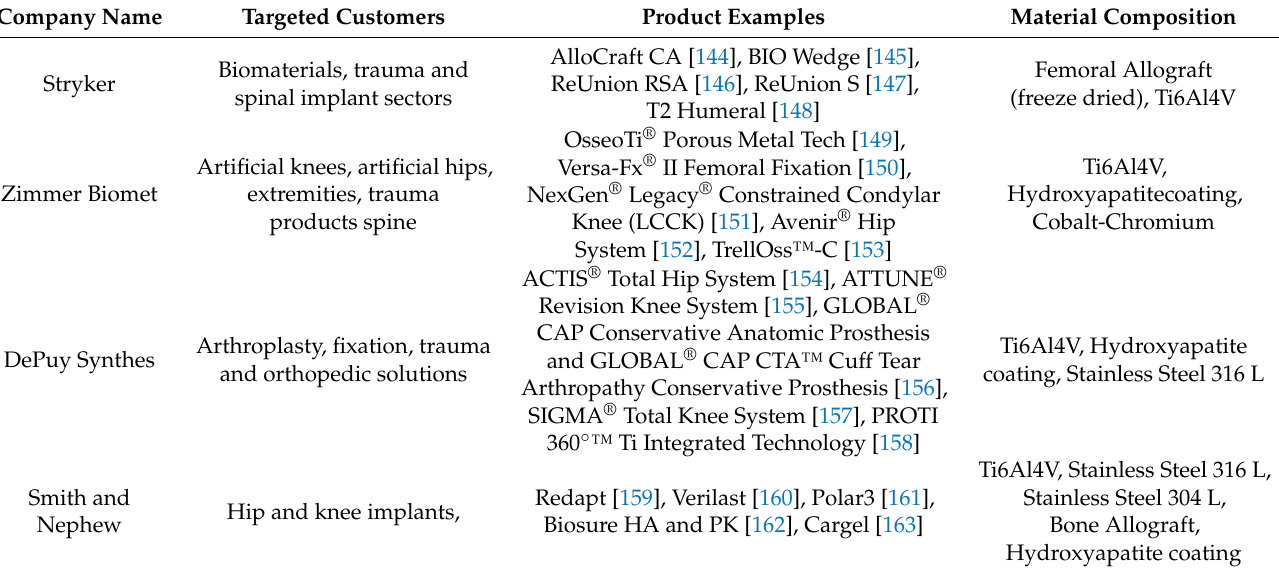
Table 8. Various spinal and orthopedic companies specializing in bone replacement.